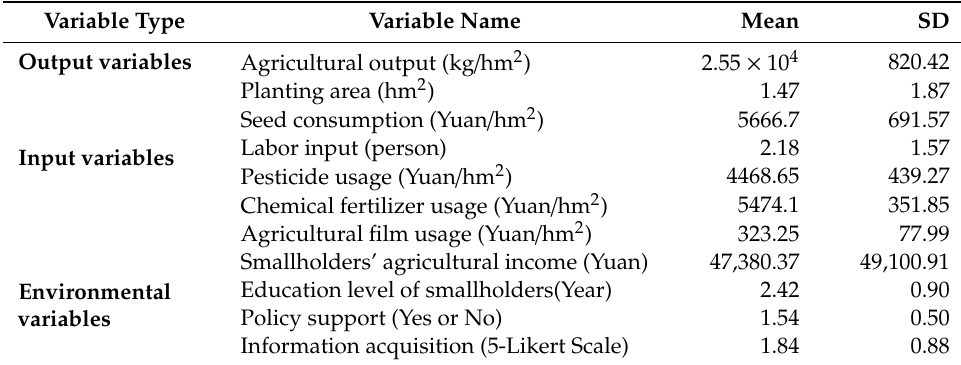
Table 2. Descriptive statistical characteristics of each